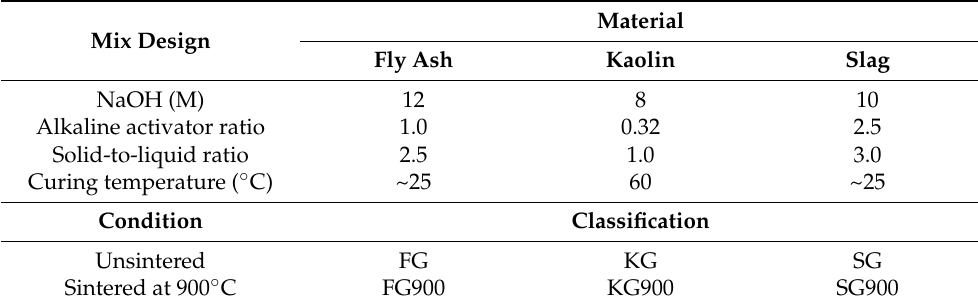
Table 2. Mixture proportion and classification of the